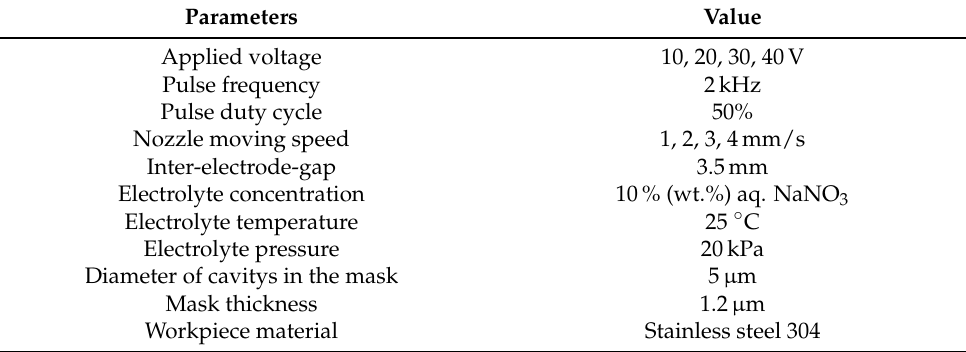
Table 3. Experimental